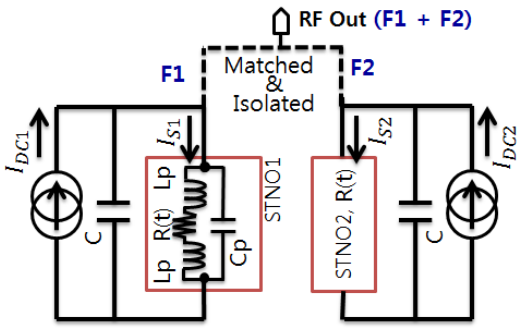
Figure 7. Simplified circuit driving the STNO. (C is the capacitance located in parallel with the STNO, and Lp, Cp, and R(t) are the parasitic inductor, parasitic capacitor, and internal resistance of the STNO, respectively).